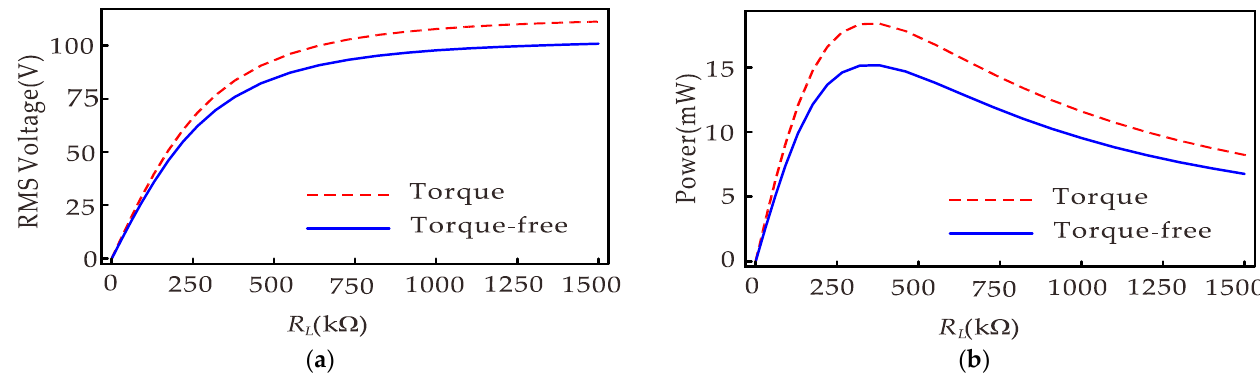
Figure 6. Piezoelectric output versus load resistance: ( a ) RMS voltage; ( b ) output power.